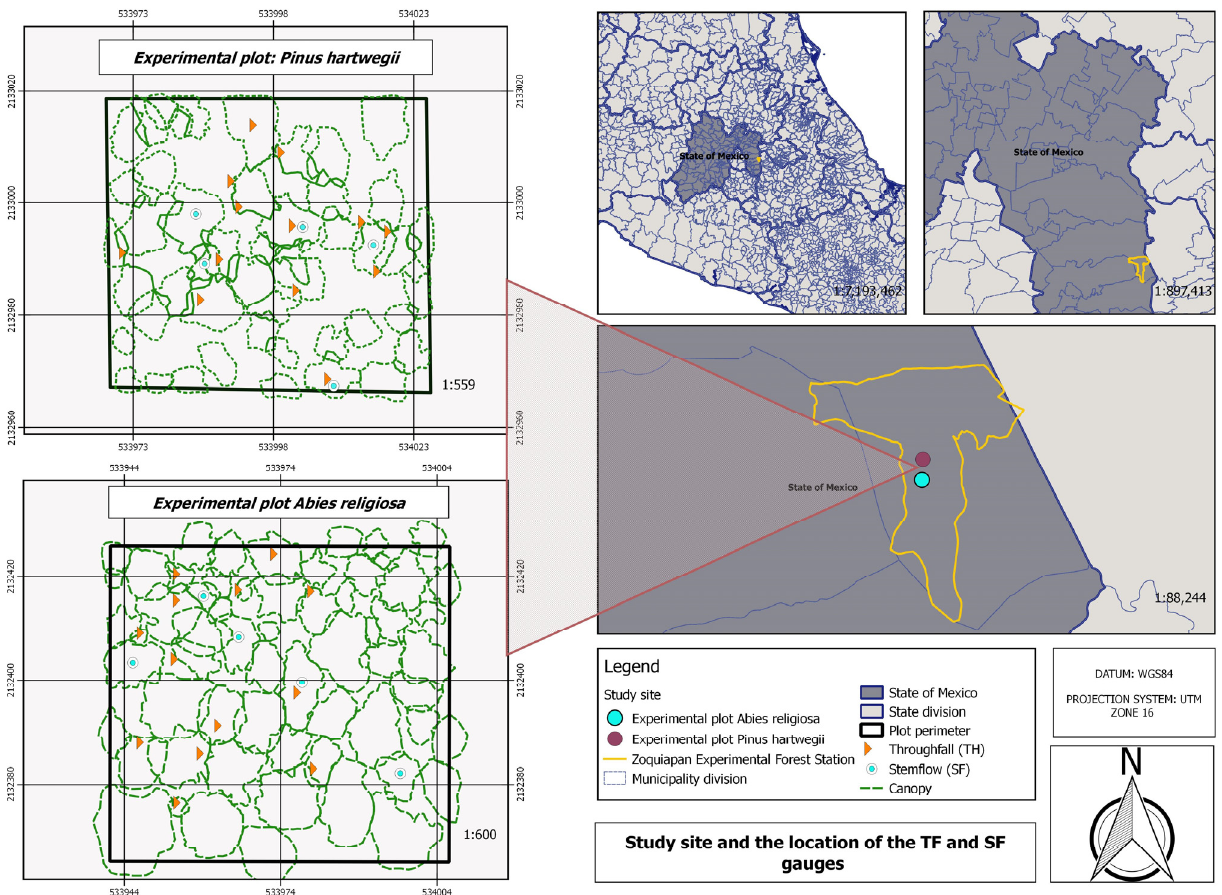
Figure 1. Study site and location of instrumentation to measure throughfall and stemflow.